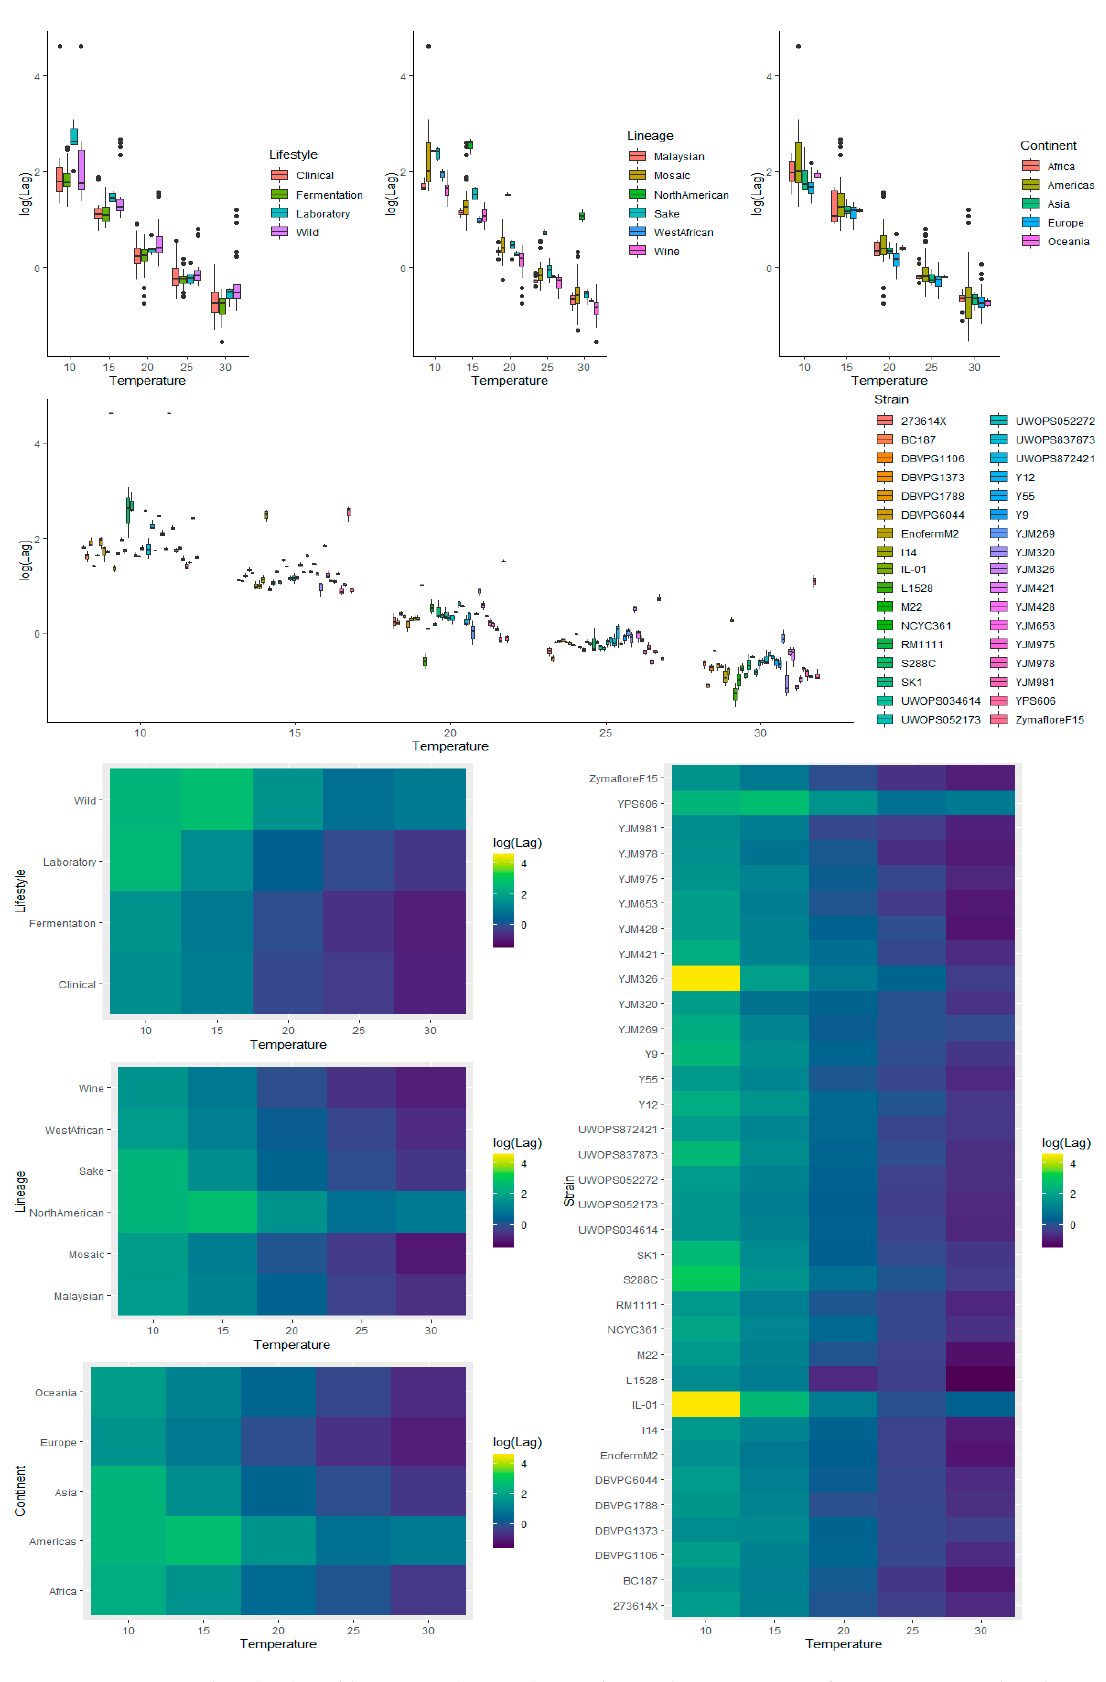
Figure 4. Box plots (top) and heatmaps (bottom) visualizing the interaction of temperature and each of the factors investigated (lifestyle, lineage, continent, and strain) on log-transformed fermentation lag time.